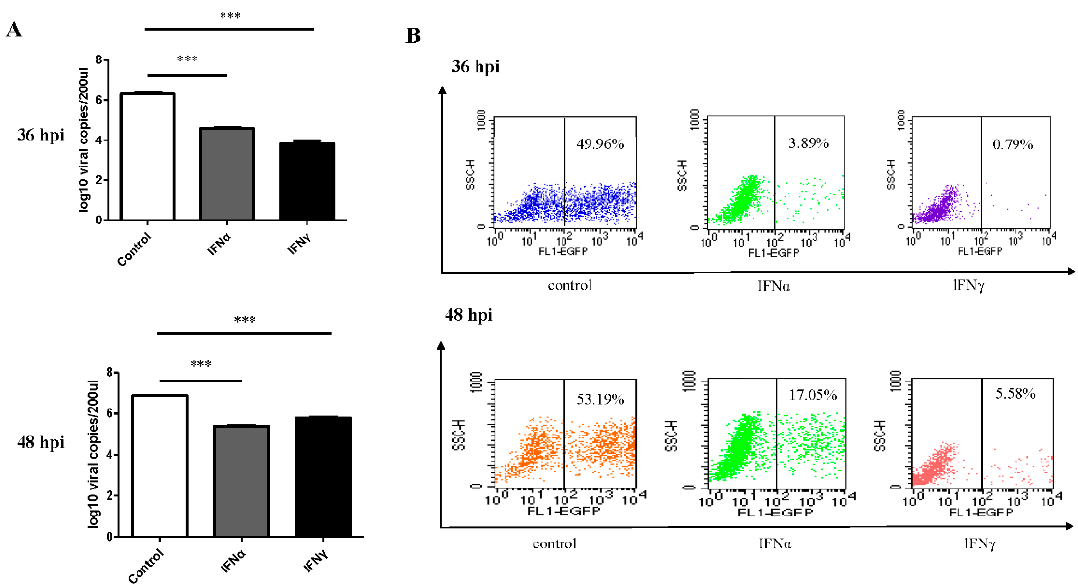
Figure 3. Effects of IFN α and IFN γ on DPV DNA copy numbers and viral replication. ( A ) DPV UL30 DNA copies were detected by RT-qPCR in DEF cells infected with the DPV strain at 36 hpi and 48 hpi after pretreatment of goose proteins (60 µg/well) from BHK21 cells transfected with the empty (negative control), or IFN α or IFN γ plasmid. The numbers of DPV UL30 gene copies was were calculated according to the standard curve. The assays were performed in triplicate wells, *** p < 0.001; ( B ) Flow cytometry analysis of DPV-EGFP positive cells from corresponding samples at 36 hpi and 48 hpi.